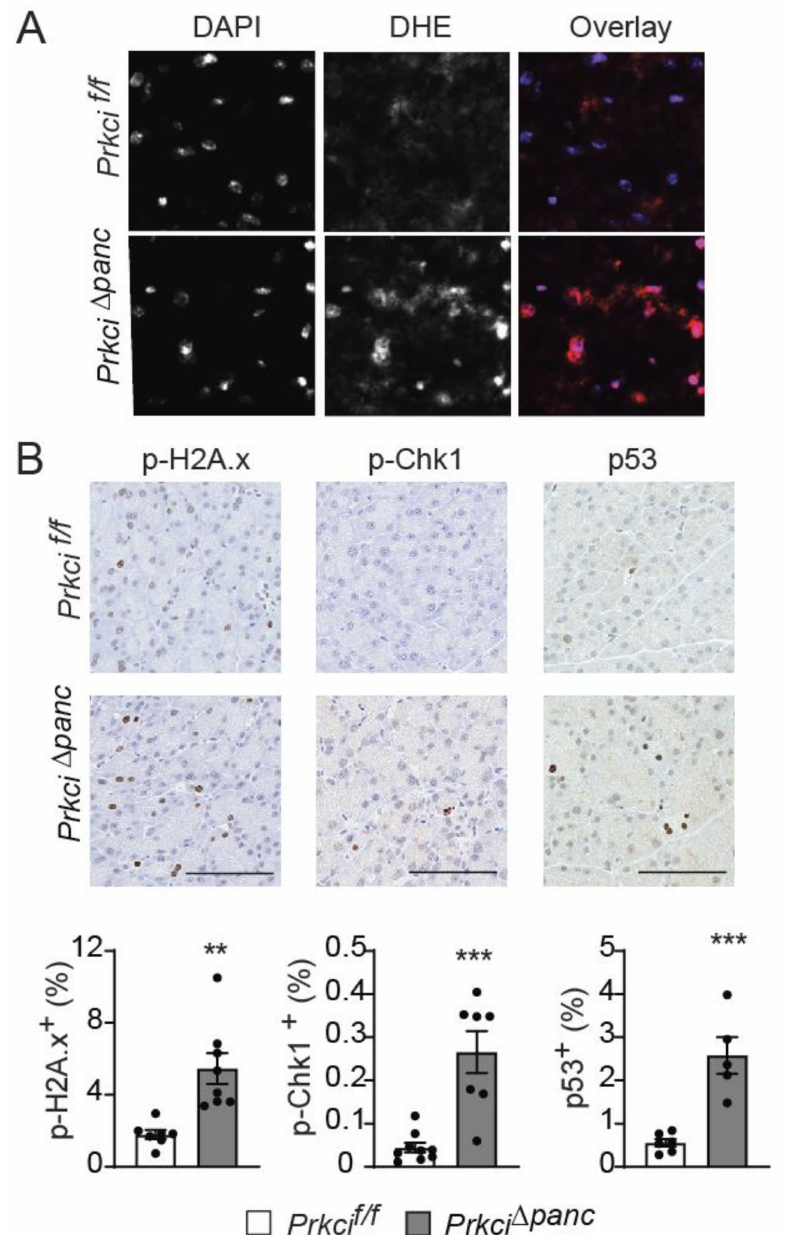
Figure 4. Loss of pancreatic PKC ι expression induces oxidative stress and DNA damage. ( A ) Representative images of superoxide detected by DHE staining and overlaid with DAPI staining in pancreata of 1.5 month old Prkci f/f and Prkci ∆ panc mice. ( B ) IHC detection of p-H2A.x, p-Chk1, and nuclear p53 in 1.5 month old Prkci f/f and Prkci ∆ panc mice pancreata. Bars = 100 µ m. Quantitative analysis of IHC staining is presented in the graphs below images. Mean ± SE is plotted; n ≥ 6. ** p < 0.01, *** p <